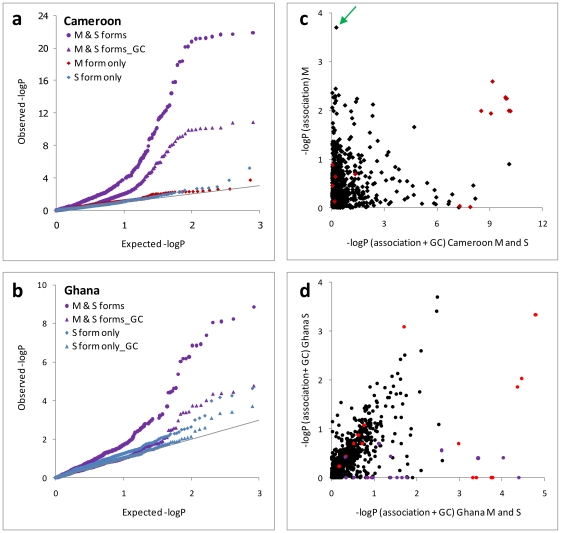
Evaluation and correction of molecular form-related stratification in association tests.(a,b) Failure to partition M and S forms leads to massive inflation of observed –logP values relative to their expected distribution (solid line). Within Ghanaian S forms genomic control (GC) is required to align results for the majority of SNPs to their expectation. (c,d) False positives (high x-axis, low y-axis values) are common in unpartitioned datasets and primarily attributable to SNPs in the sodium channel (red) and 2L or X speciation island regions (defined conservatively as <2Mb and >20Mb respectively [24] (purple) in the Ghana dataset, though in Cameroon, SNPs in other areas (black) appear as false positives, which also shows a possible false negative (green arrow).